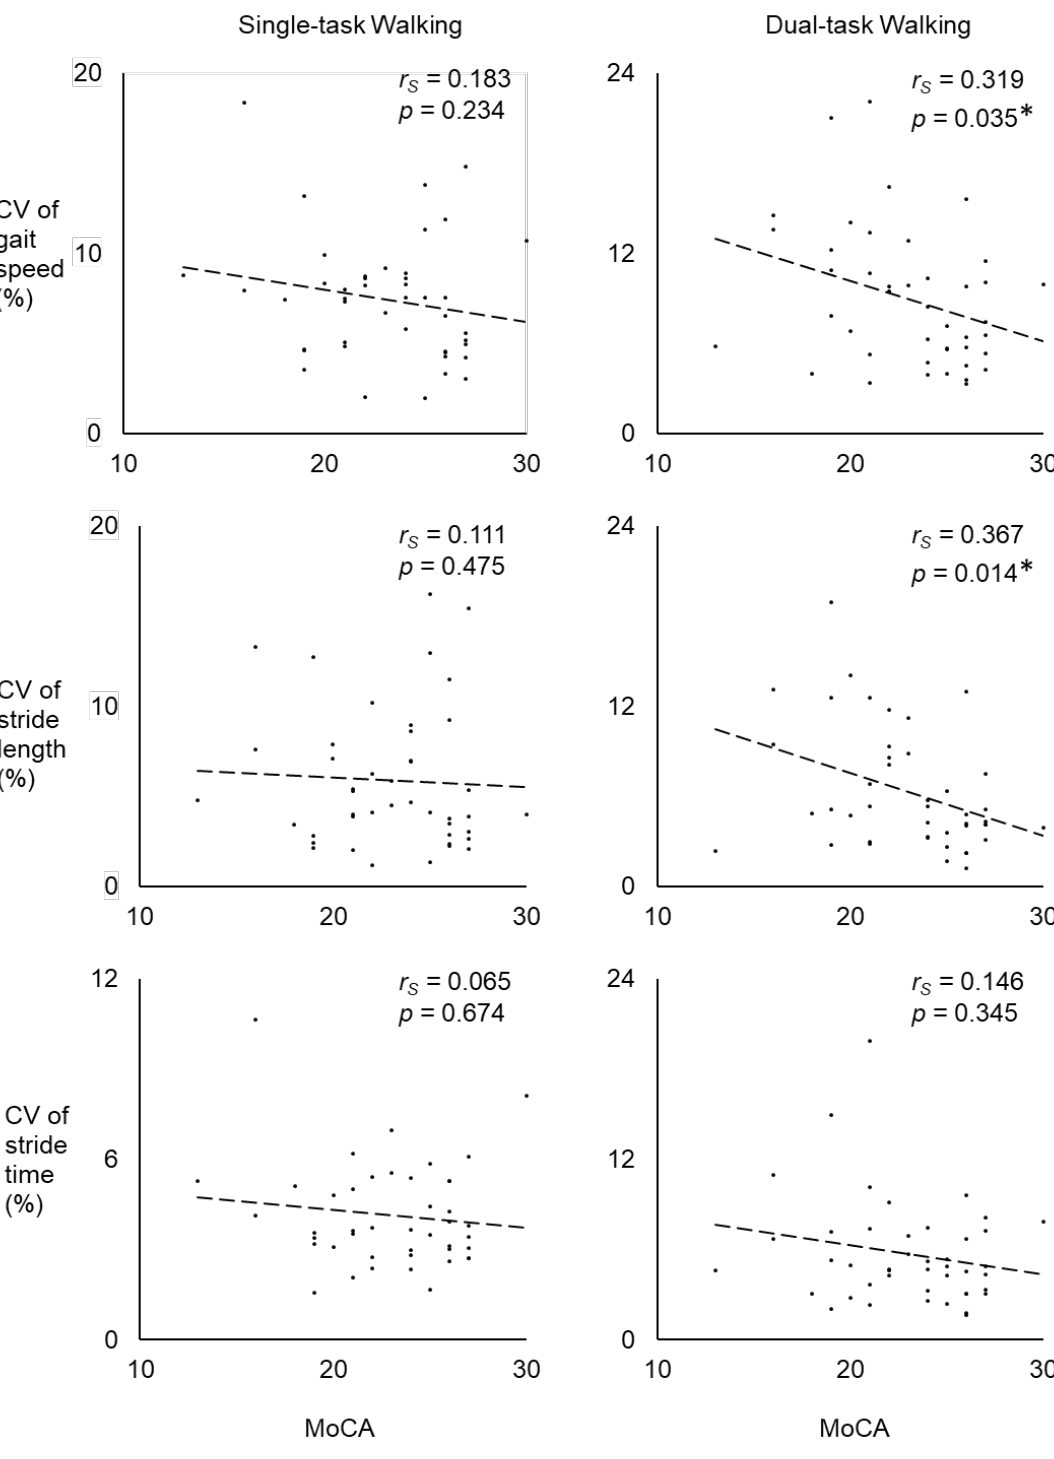
Figure 2. Spearman correlations (r s ) between MoCA scores and CV in gait parameters across all participants during single-task walking and dual-task walking. Asterisks denote significant correlations between MoCA scores and gait variables.